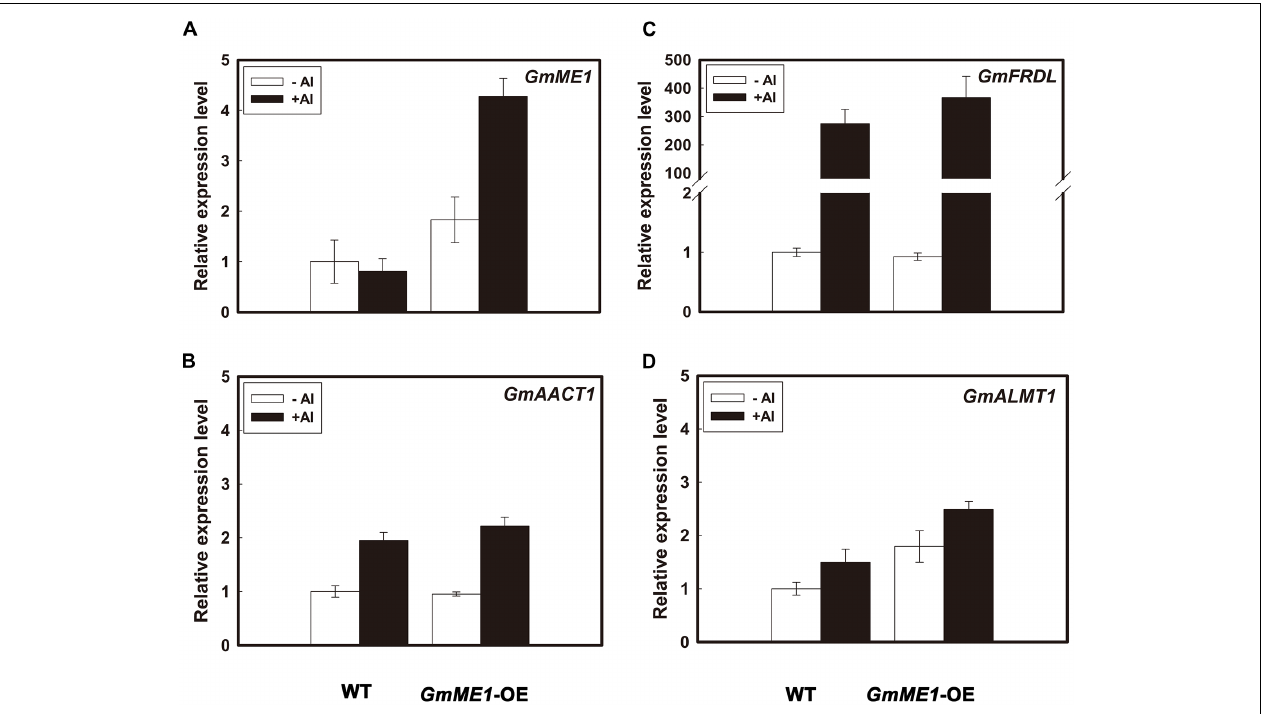
FIGURE 7 | The transcriptional levels of GmME1 (A) , GmFRDL (B) , GmAACT1 (C) , and GmALMT1 (D) in transgenic hairy roots under Al stress. Both transgenic and WT hairy roots were exposed to 0.5 mM CaCl 2 solution (pH 4.5) with or without 30 µ M AlCl 3 . Ten 0- to 1-cm root apices were excised from each treatment at 4 h for RNA isolation. Quantitative real time PCR was performed to study the transcriptional expression of (A) GmME1 (B) , GmFRDL , (C) GmAACT1 and (D) GmALMT1 . Data are given as the mean ± SD ( n =